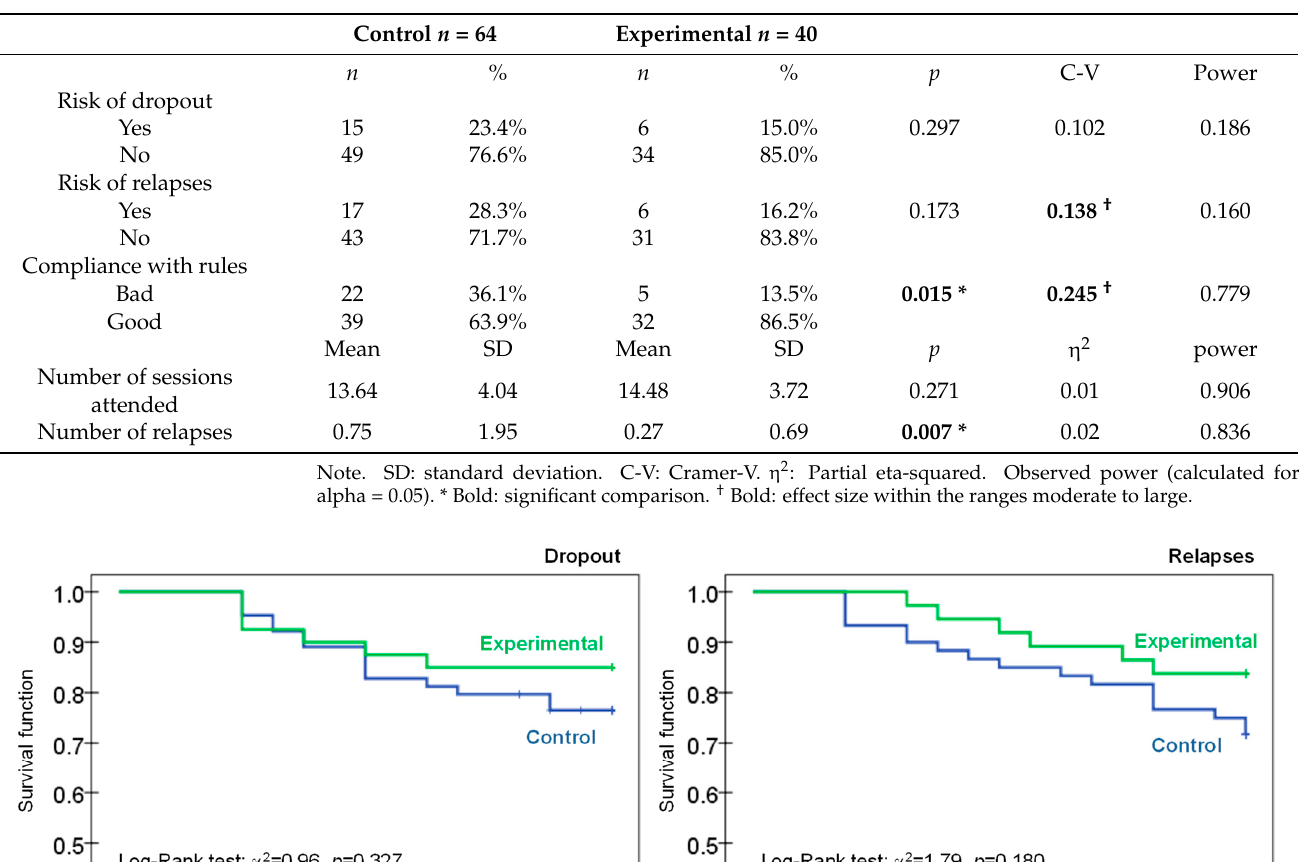
Table 3. CBT outcomes: dropout, relapses and compliance with the CBT rules.